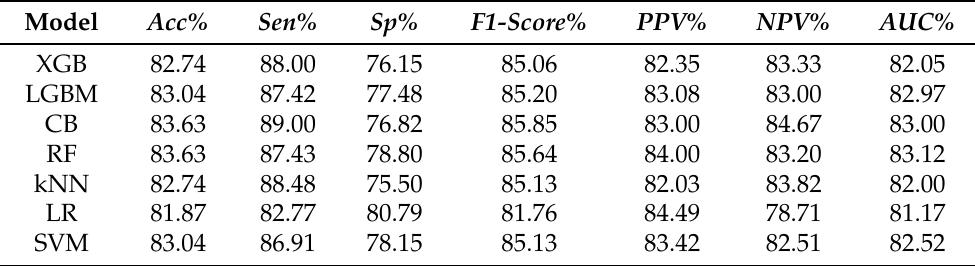
Table 3. Classification performance measures across ensemble and traditional models for 2 PSG